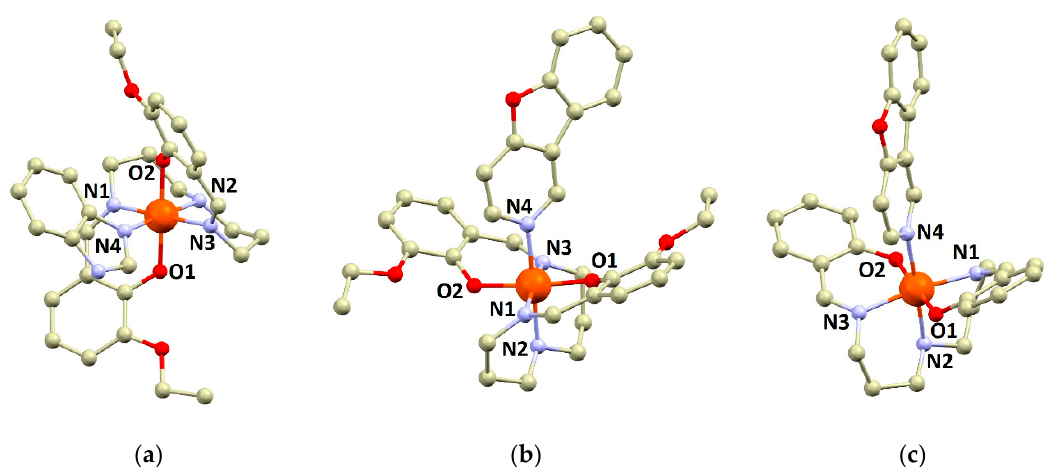
Figure 1. Depiction of the molecular structures of [Fe(3EtO-LA)(L1 a )] + in 1a ( a ), [Fe(3EtO-LA)(L1 b )] +